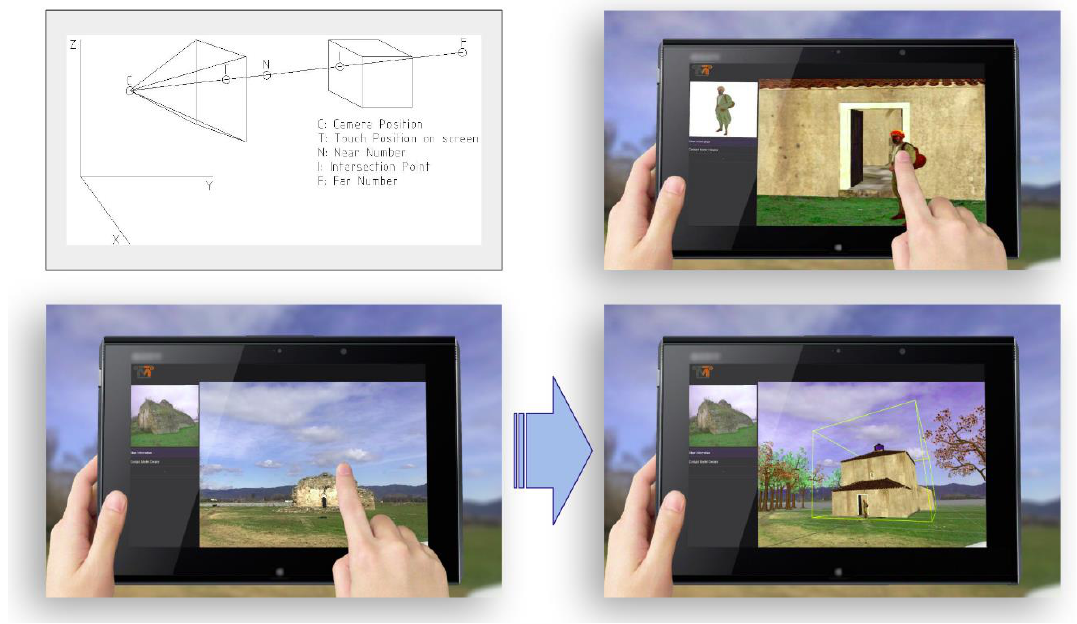
Figure 10. Interacting with real (mixed) and virtual objects via the touch screen.